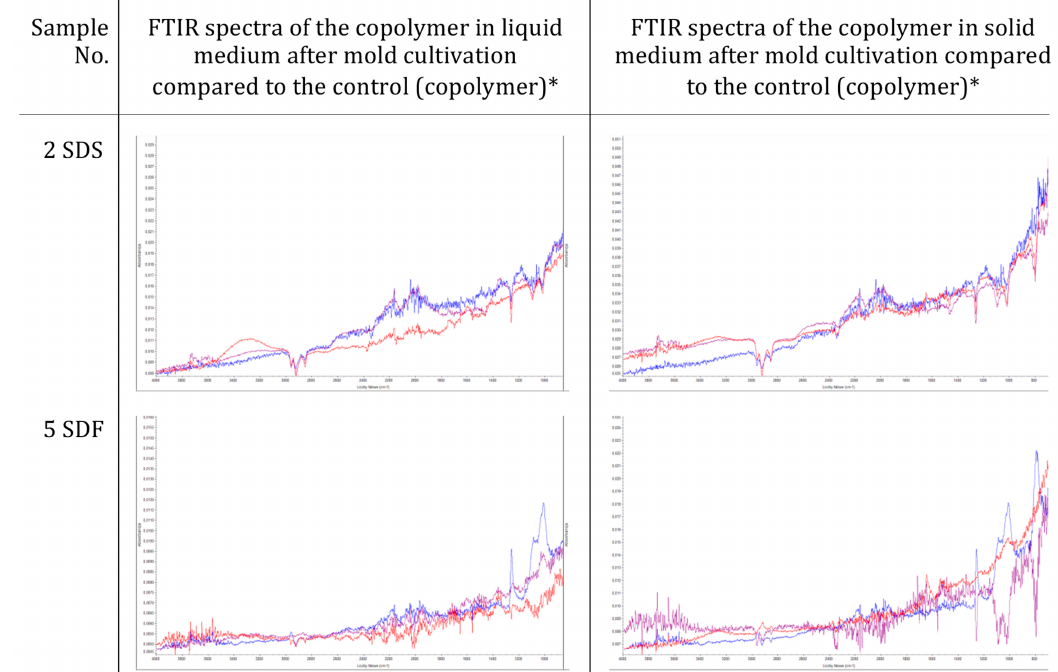
Figure 4. FTIR spectra of the selected sulfur copolymers after incubation with molds (blue—copolymer before incubation, purple—after 14 days of mold cultivation in the medium without carbon source, red—after 14 days of molds culture in the medium with a carbon source).